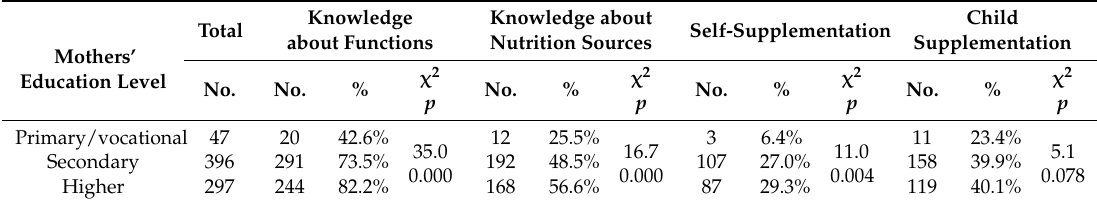
Table 5. The influence of level of mothers’ education on knowledge and supplementation of vitamin D ( n = 740) ( p =